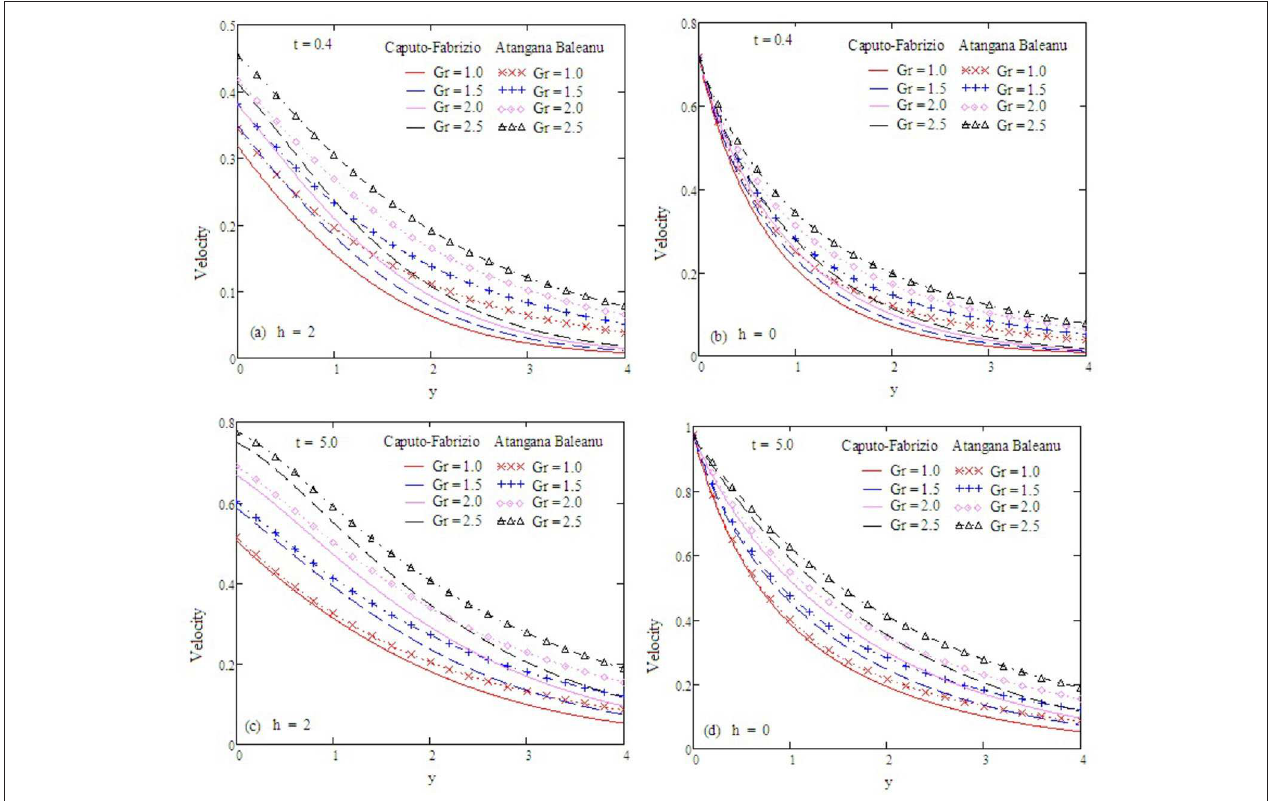
0.2, α 0.5, P reff 0.1, G m 0.75, k p 1.5, S c 0.5, and M = = = = = =